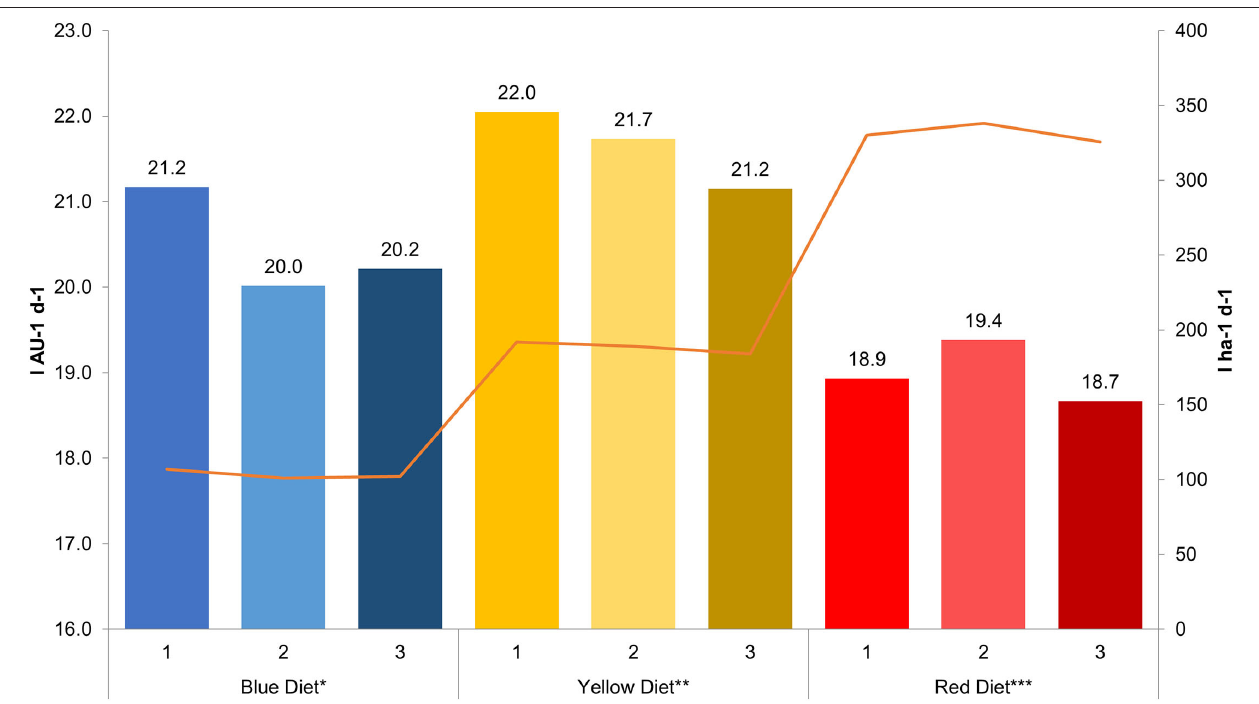
FIGURE 1 | Milk production per three cycles for the diets with Altoandina and the Kikuyu diet (each cycle was a 7-day evaluation, the total evaluation period was 21 days). * 100% Kikuyu grass, ** 35% Altoandina silage and 65% Kikuyu grass, *** 65% Altoandina silage and 35% Kikuyu grass.